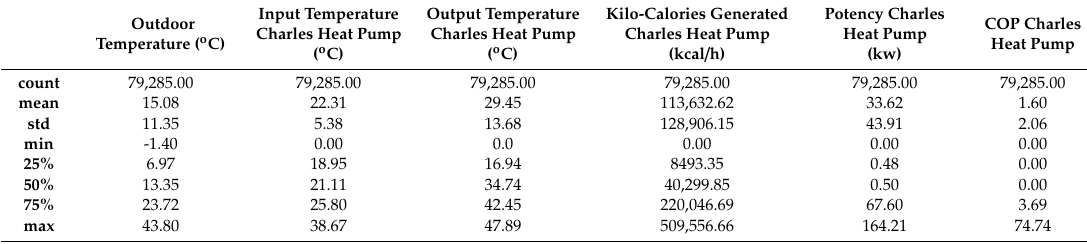
Figure 5. Influence of the variables in the variable ‘COP cold group 1 ′ . Table 6. Partial table with some statistic values of some HVAC system variables.